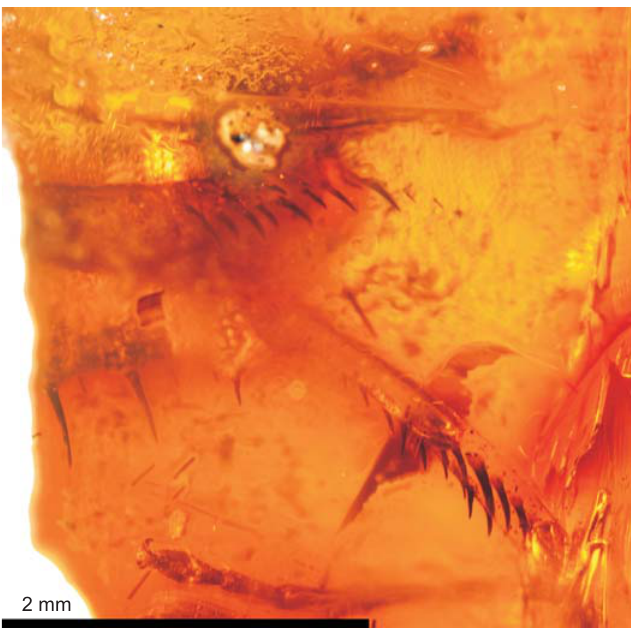
Fig. 2. Fore legs of Chaeteessidae gen. at sp. incertae sedis, MNHN-F. A71142, Le Quesnoy, France, Eocene.